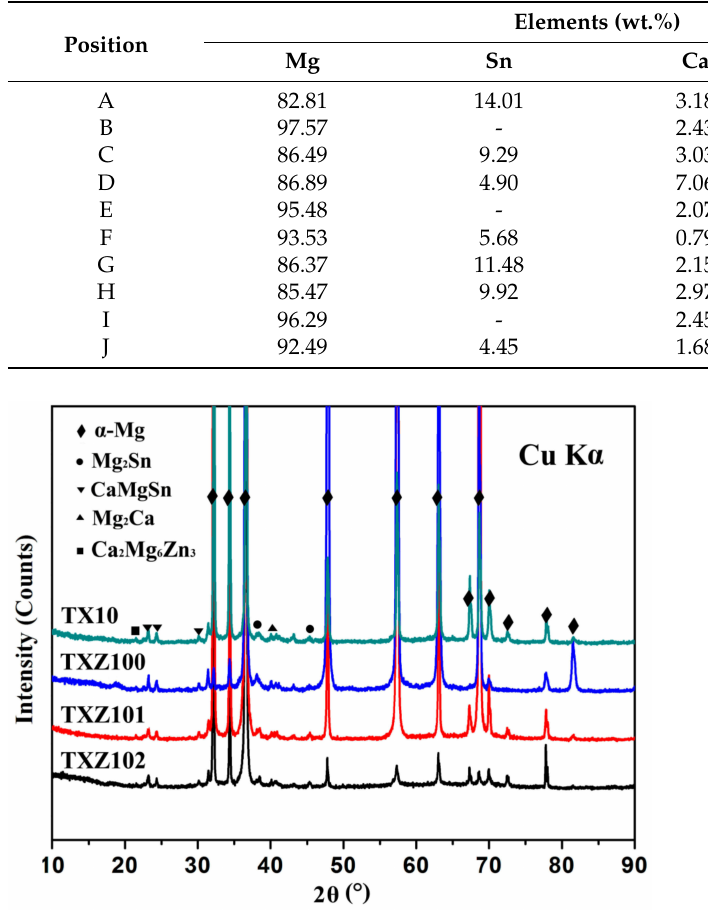
Figure 2. XRD patterns of the as-homogenized Mg-1.0Sn-0.5Ca-xZn series